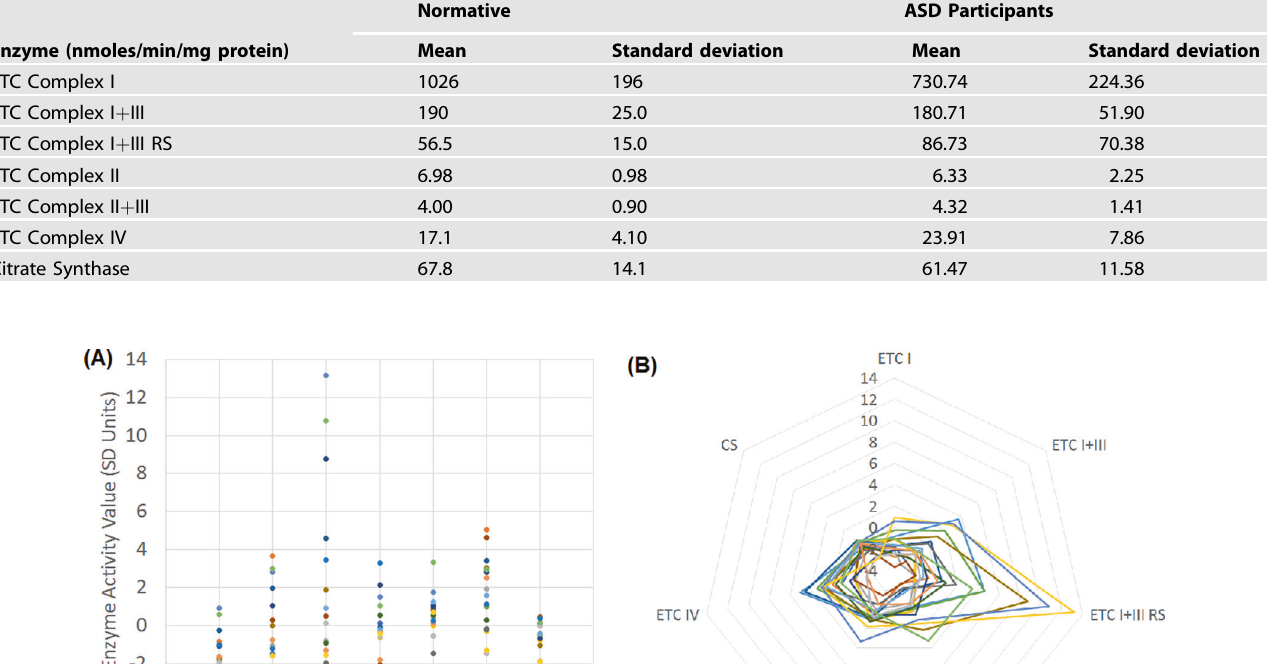
A mixed-model regression was used to determine the relationship between mitochondrial enzyme activity and mitochondrial morphology. Parameters for enzymes found to be non- signi fi cant (cutoff p < 0.001) were eliminated from the model. Two models were analyzed. Model 1 included all mitochondrial enzyme variables. Model 2 added the transformed variable of mitochondrial enzyme activity parameter is provided in Supple- mentary Table 1 while parameter values are provided in Table 5.